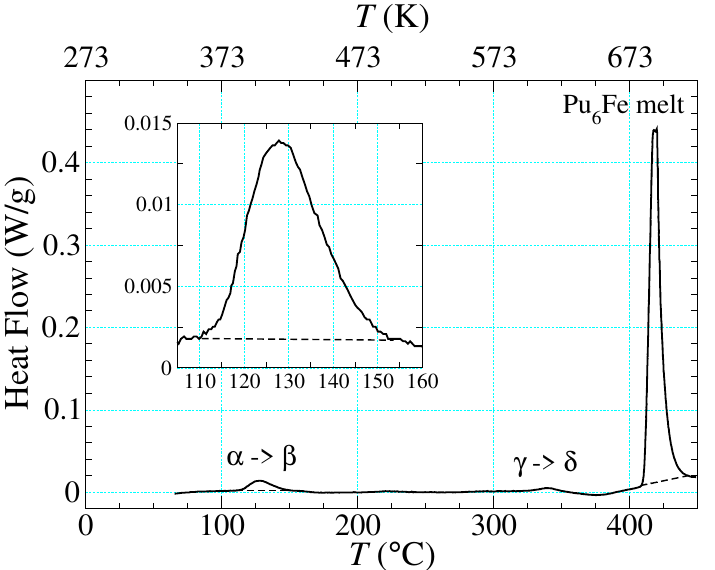
Figure 1. Third heating cycle of Schwartz, et al., reproduced from Figure 3 of Reference [3]. Peaks corresponding to phase changes in pure Pu or Pu 6 Fe are